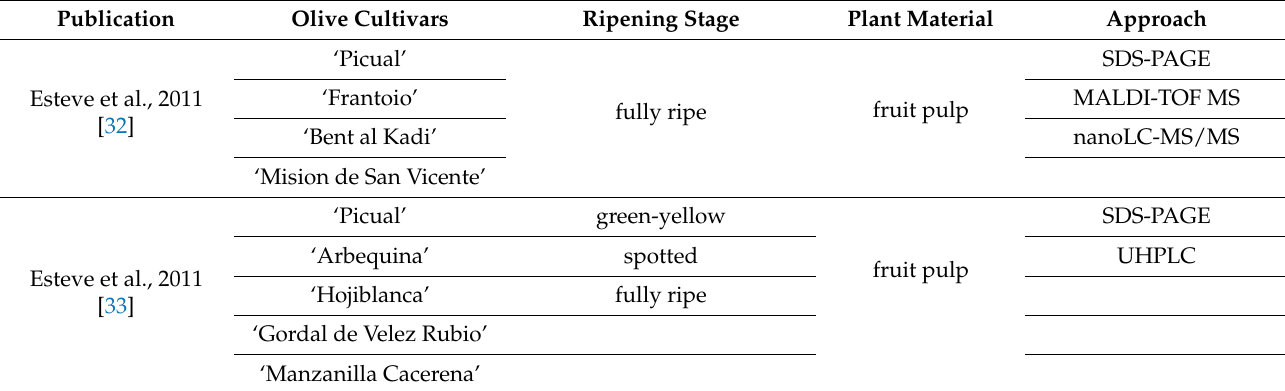
Table 3. Proteomics analyses using gel or gel-free approaches demonstrated key features of olive ripening processes in previously published